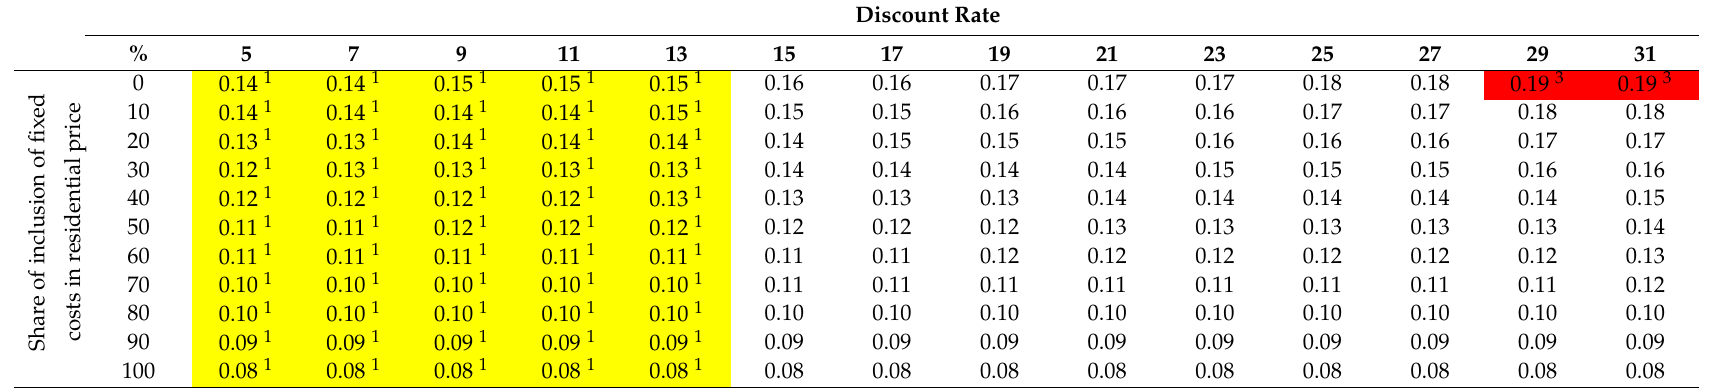
Table 5. Dependence of nonresidential LCOE on discount rate and on share of inclusion of fixed costs in residential price in case two TS are